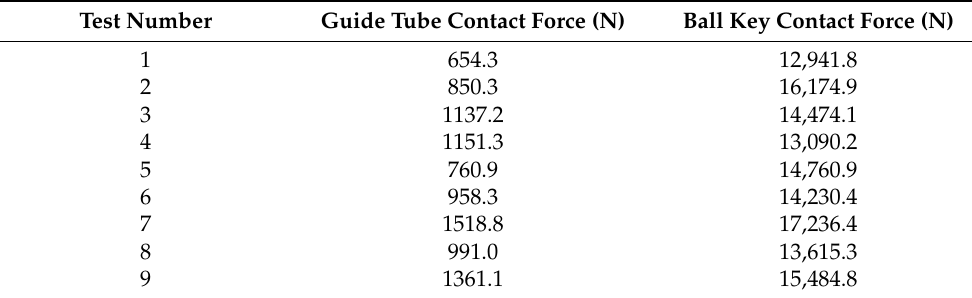
Table 3. Contact force of flexible joint under different